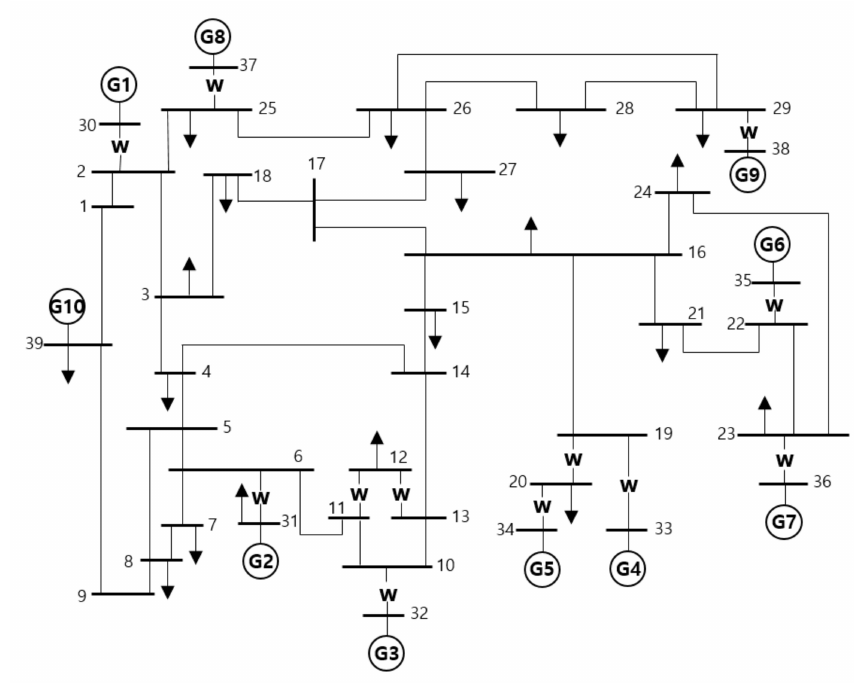
Figure 4. IEEE RTS 39-bus.